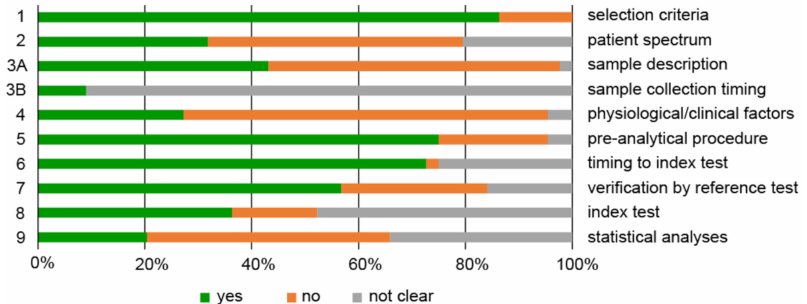
Figure 3. QUADOMICS scoring of all studies included. Proportion of studies with answers “yes”, “no”, or “not clear” to each of the selected signaling questions. Each signaling question is numbered on the left, and a short description of each question is given on the right. The detailed scoring is given in Supplementary Tables